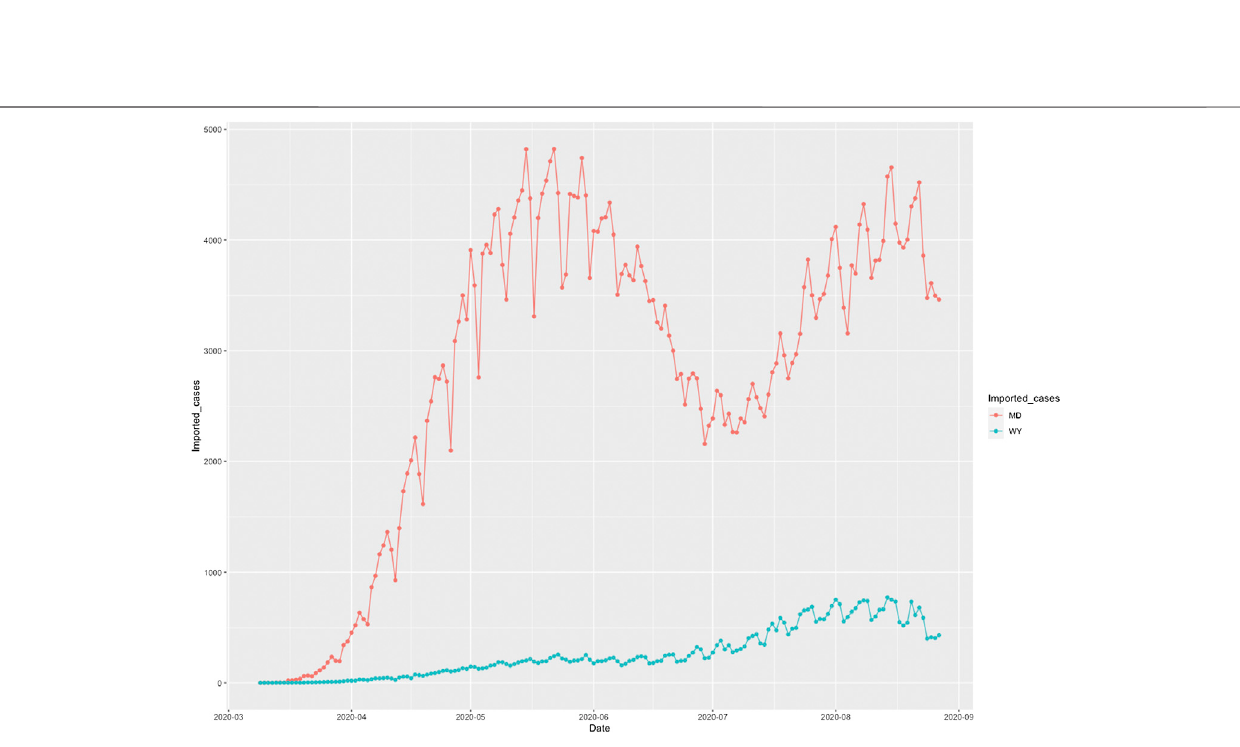
Frontiers in Applied Mathematics and Statistics |